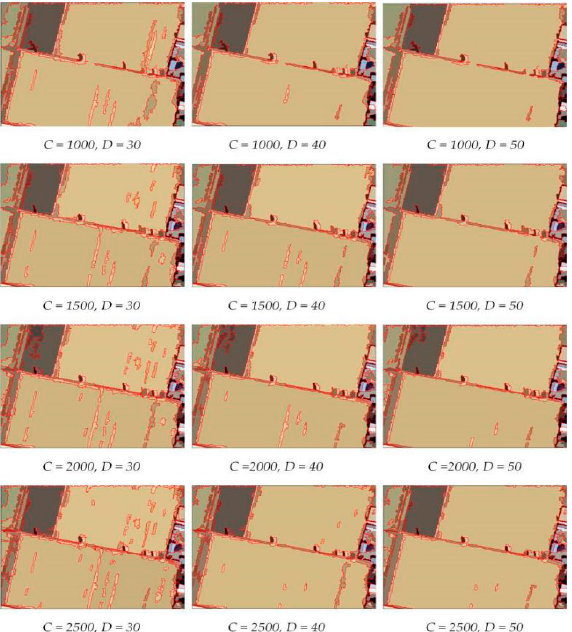
Figure 8. Some important segmentation results of cultivated land boundaries using the Luv- RMWS.